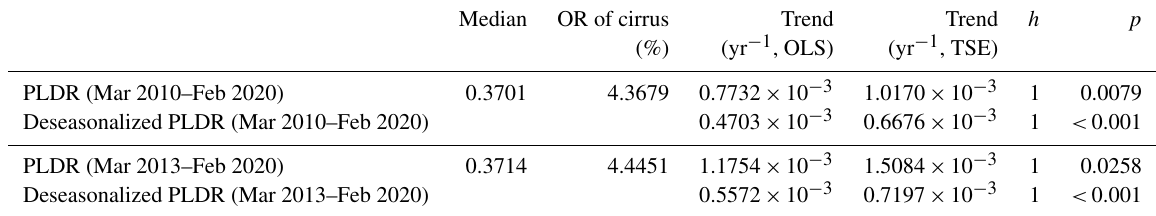
Table 1. Long-term trends of monthly values of particle linear depolarization ratio (PLDR) within the typical cirrus altitude range from 6 to 13km derived from both day- and night-time data during the period from March 2010 to February 2020: Comparison between two methods of the ordinary least square (OLS) estimator and the Theil–Sen estimator (TSE), including the Mann–Kendall (MK) significance test.